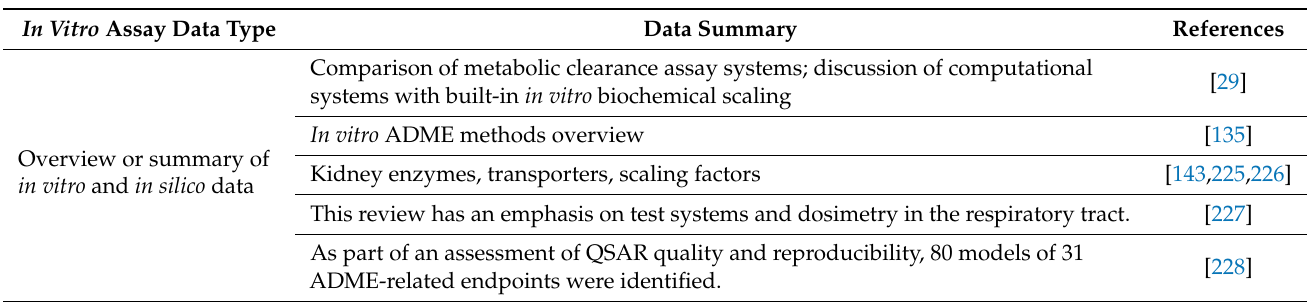
Table 4. List of resources for in vitro assay